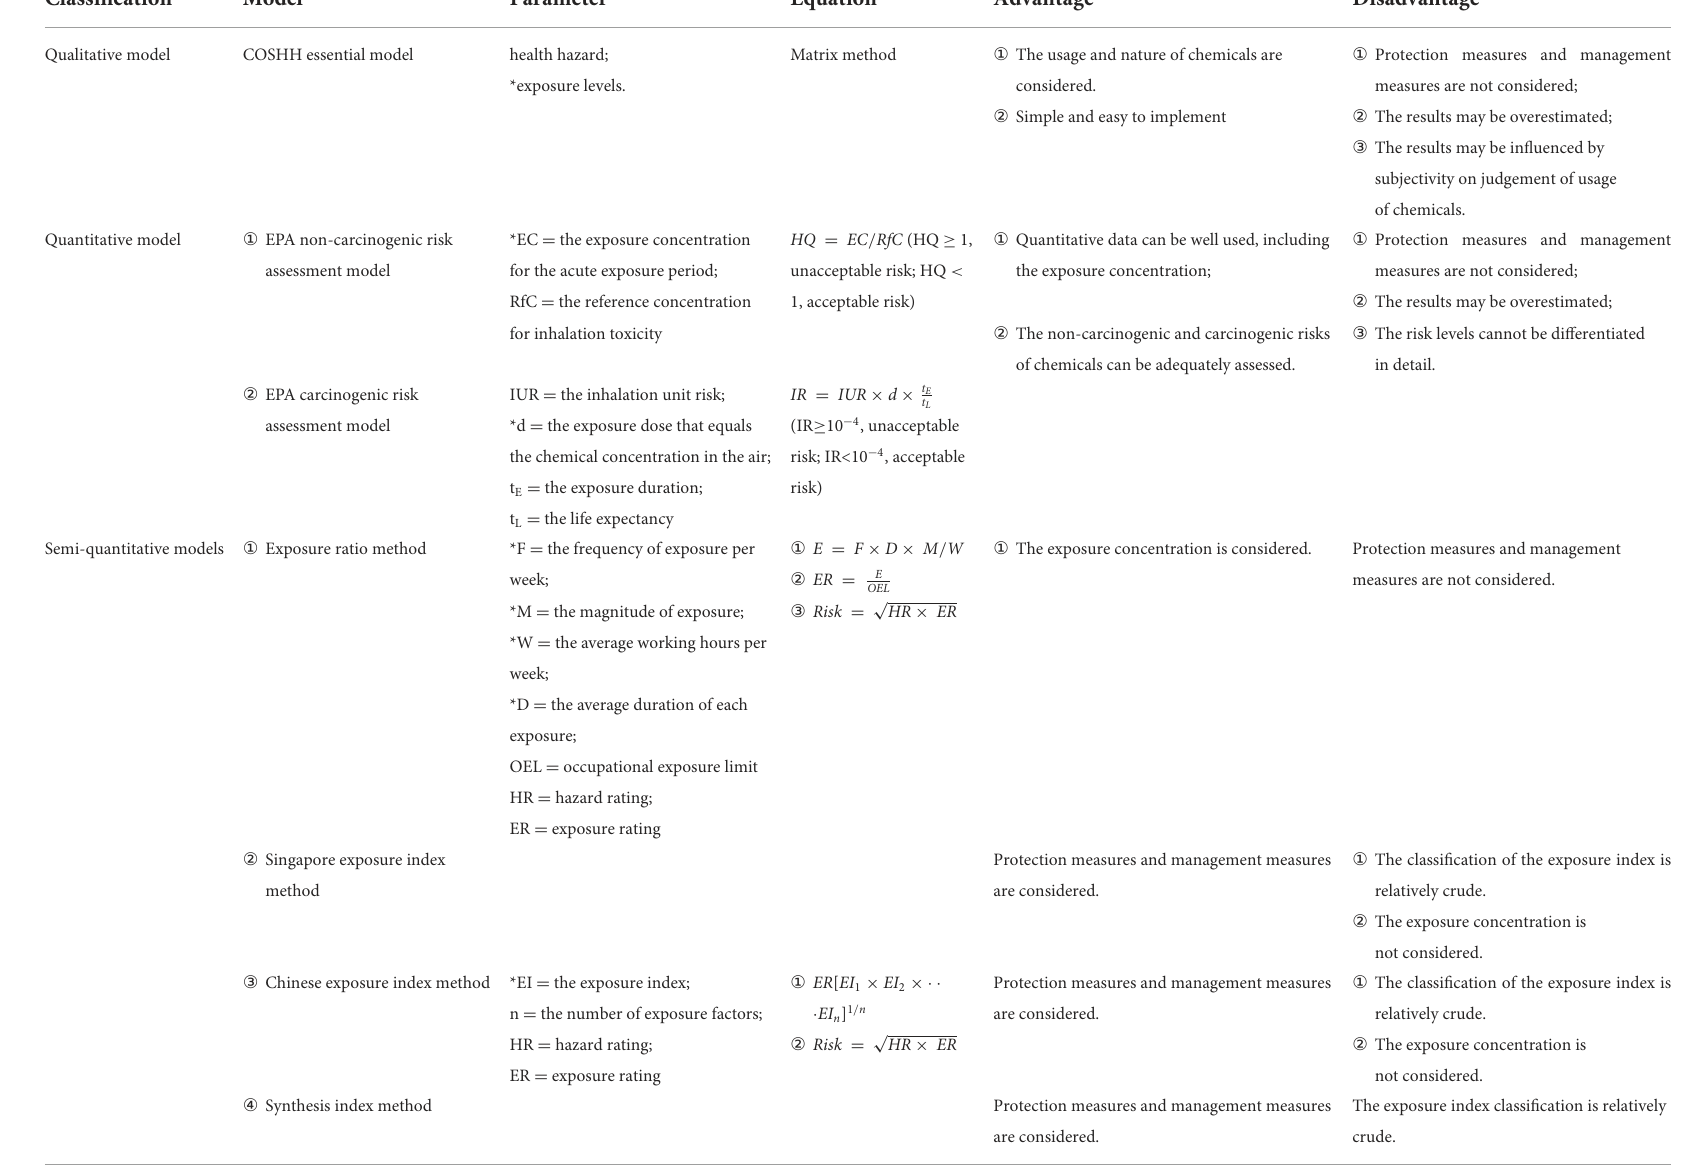
TABLE 6 An overview of the application of risk assessment methods relevant to this